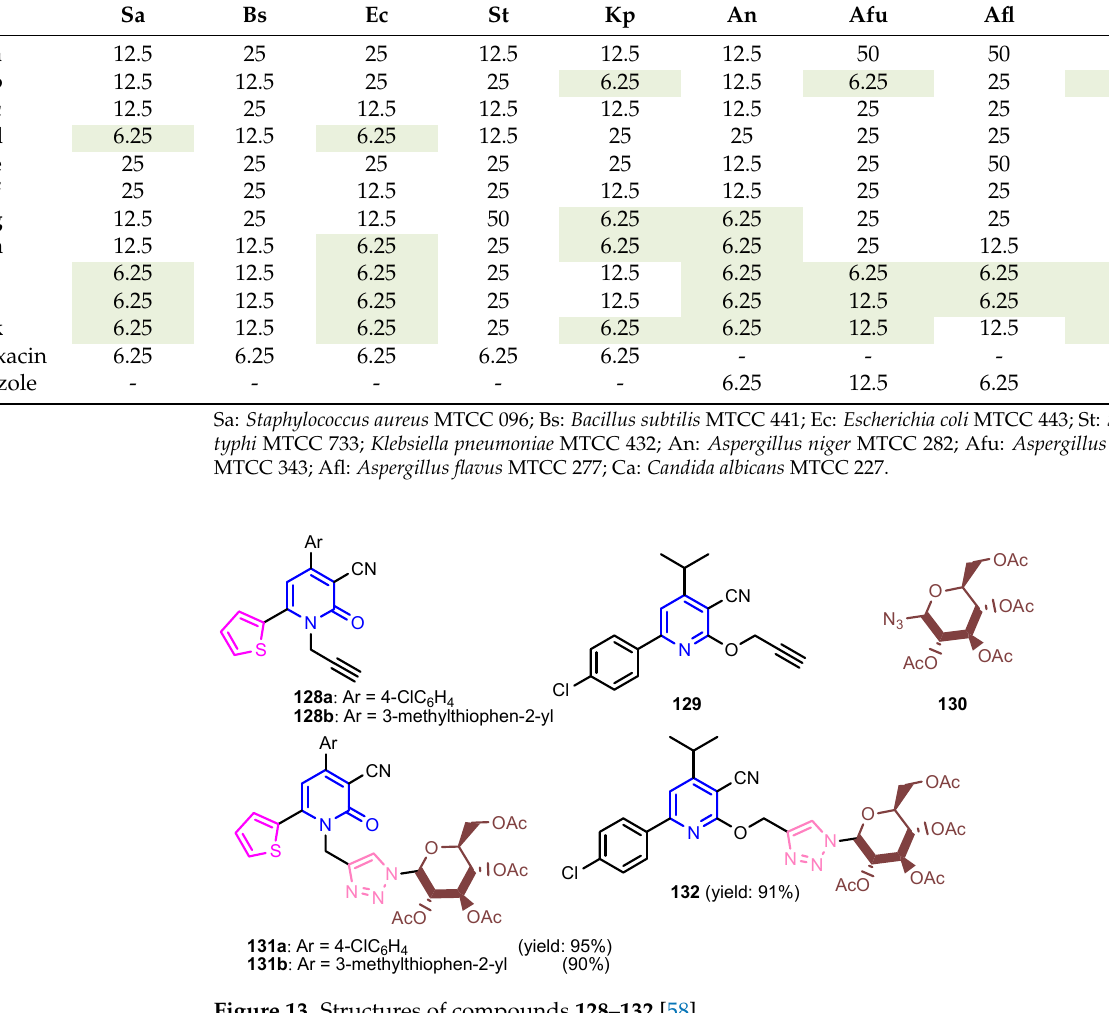
Figure 12. Structure of 1,2,4-oxadiazol-coumarin-pyridines 121 and 122 . Table 6. Antimicrobial activity (MIC values in µ g mL − 1 ) of pyridine triazoles 122a − 122k [57] . Compd.